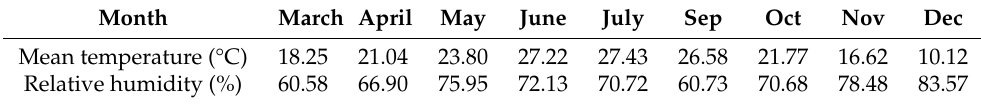
Table 1. Air temperature and relative humidity observed for both cropping